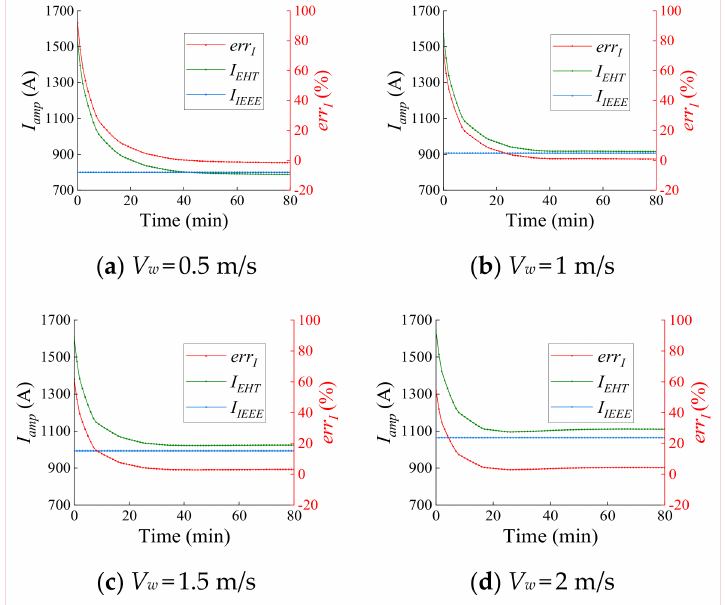
Figure 11. Comparison of conductor ampacity results from EHT model and IEEE